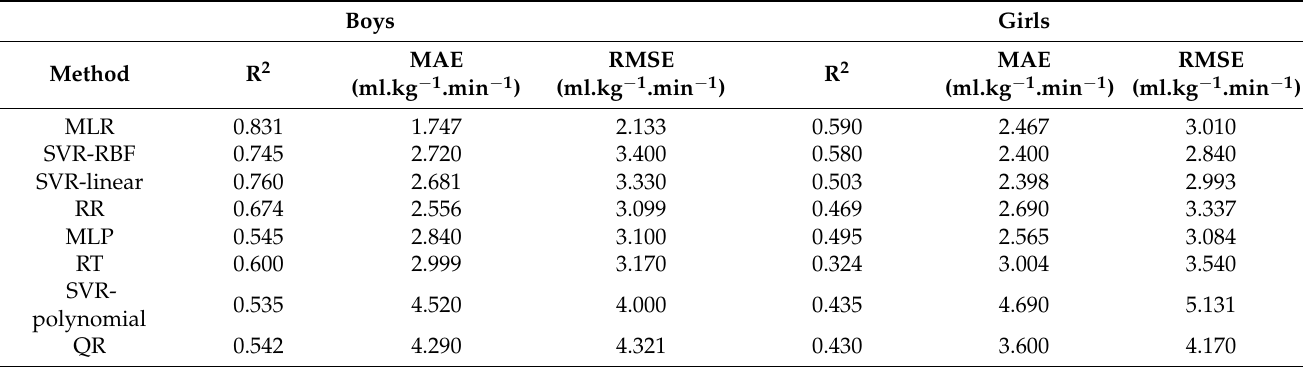
Table 4. Performance evaluation by